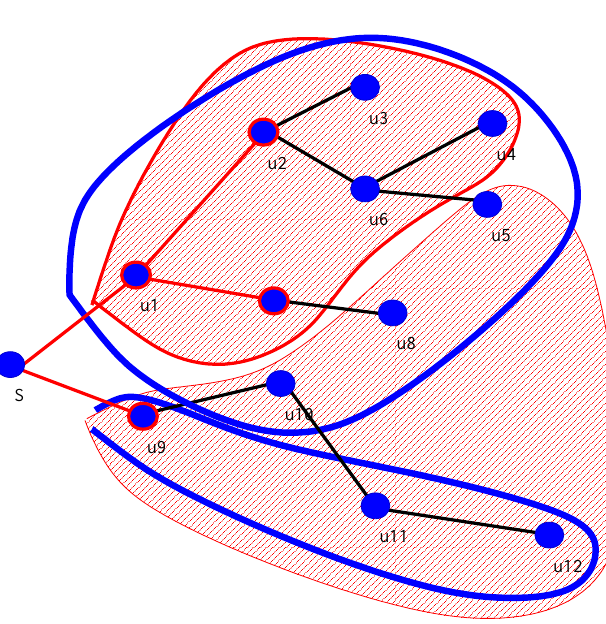
Figure 3. Illustration of sink allocation over